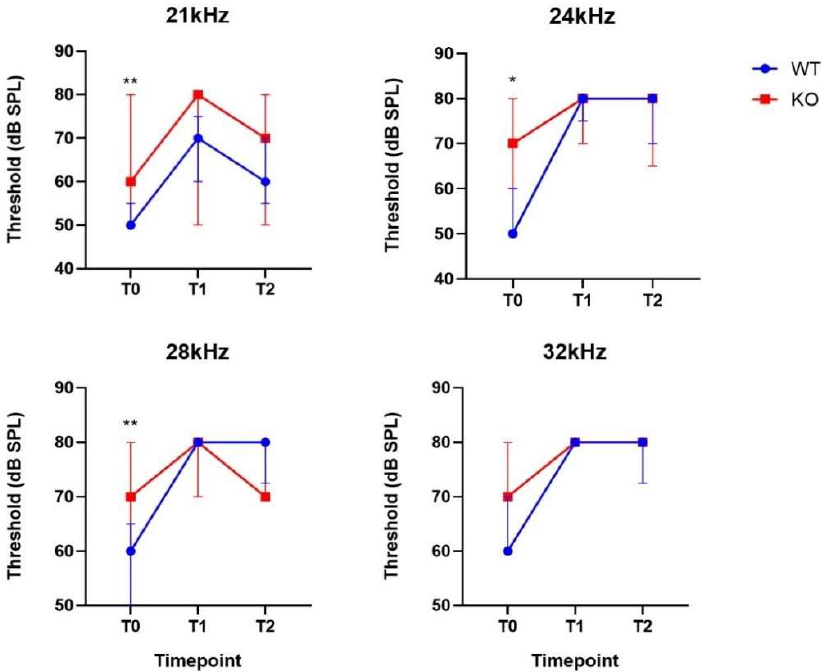
Figure 3. DPOAE thresholds at different time point (T0 = baseline, T1 = 48 h post-noise and T2 = one-week post-noise) between Coch +/+ ( n = 13) and Coch − / − mice ( n = 13) that were exposed to noise at frequencies with a significant interaction between genotype and time. Data are represented as median with interquartile range. * indicates p < 0.05; ** indicates p < 0.01.